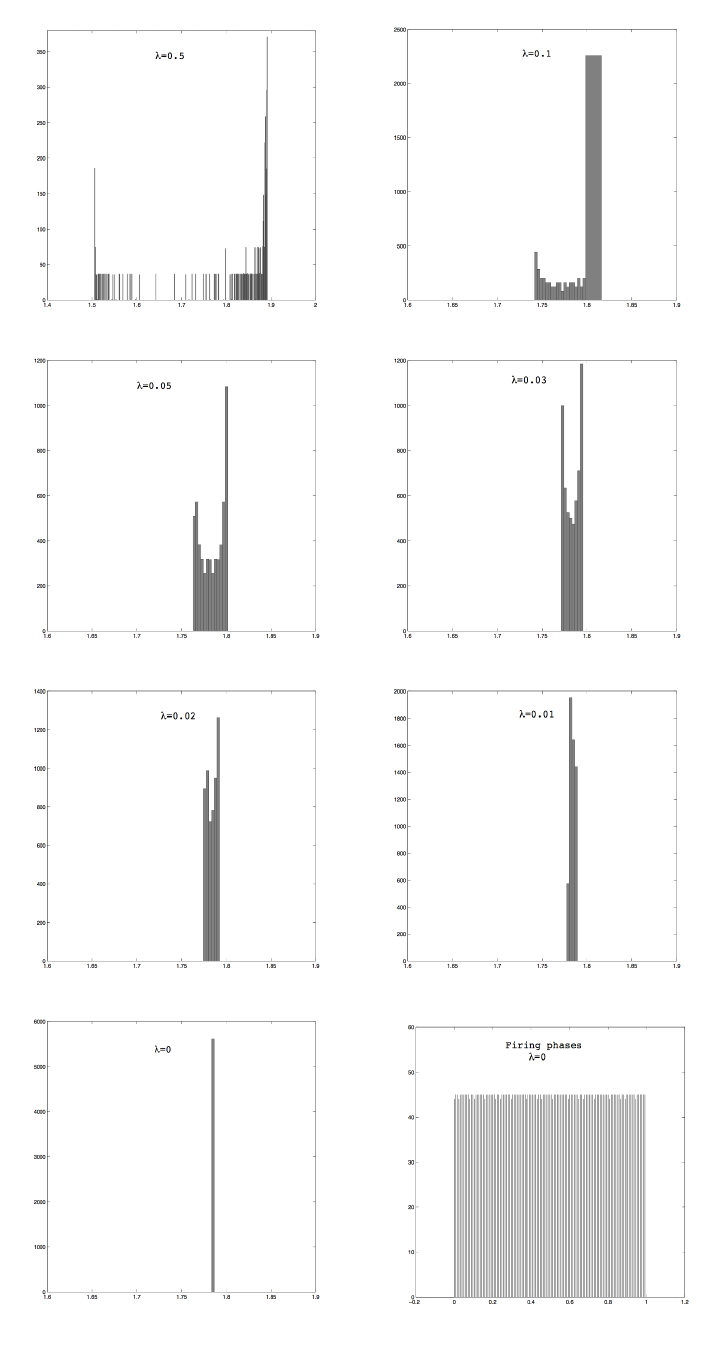
Figure 1. Histograms of interspike-intervals for the model ˙ x = ax 2 + λ sin(2 πt ) + κ ( a = 0, κ = 0 . 5). Additionally, bottom right: histogram of firing phases for λ =